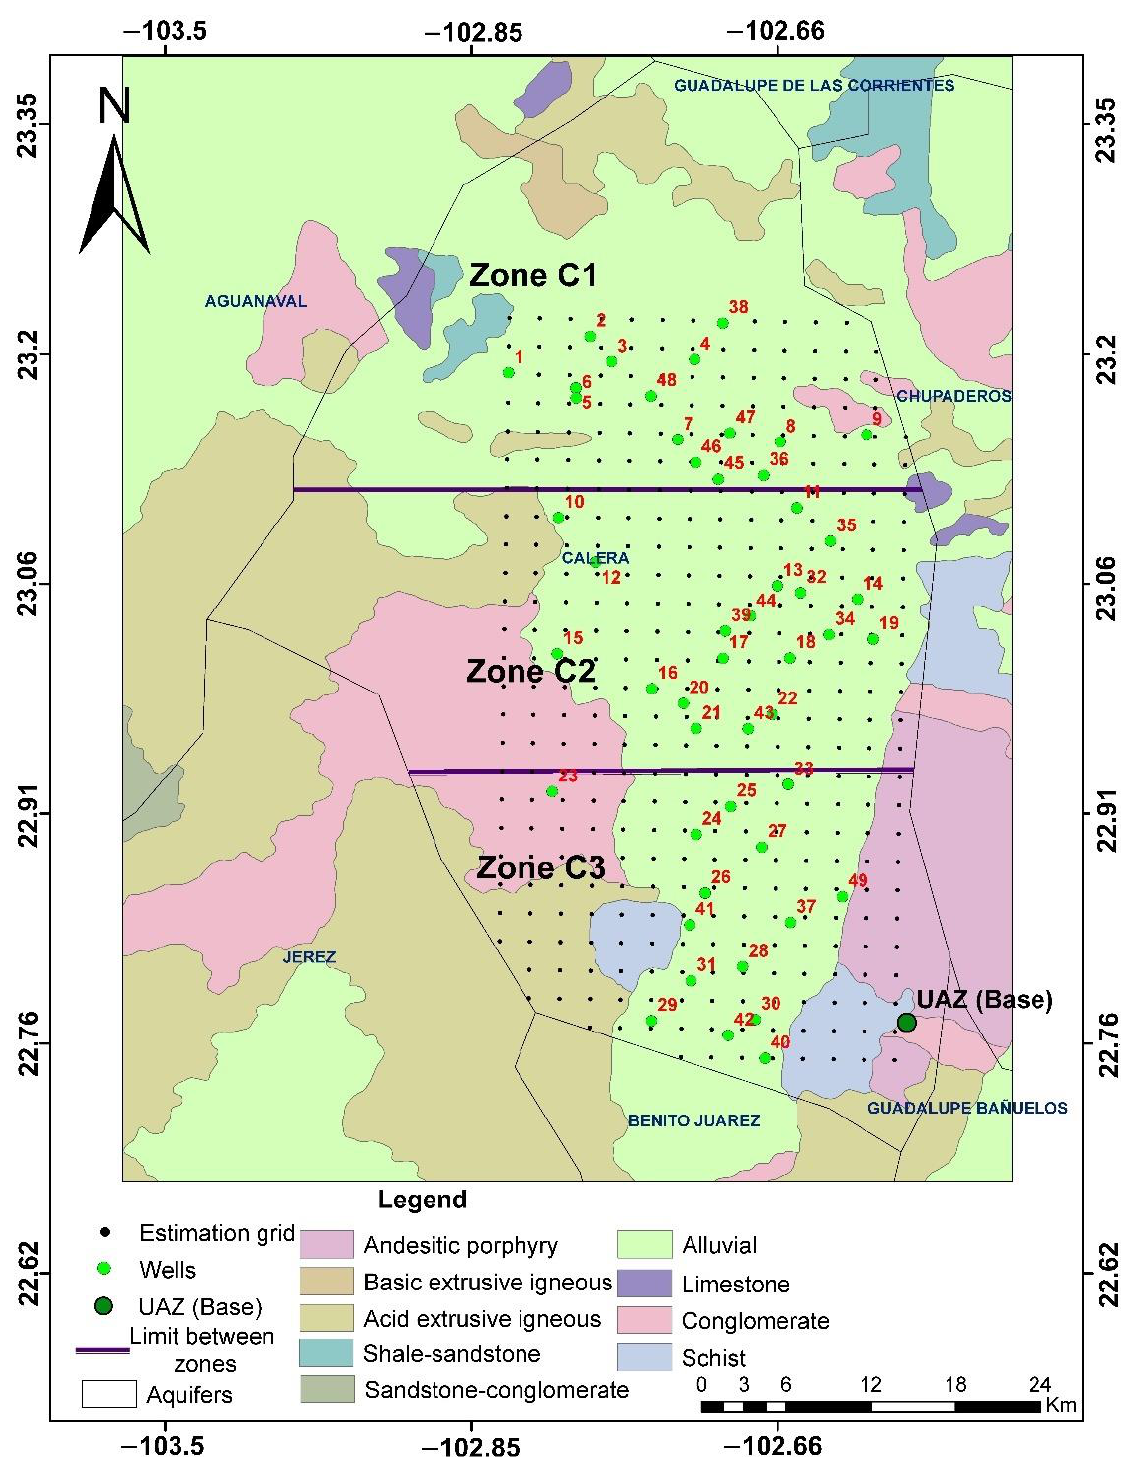
Figure 2. Monitoring sites, estimation grid, and zones C1, C2 and C3 considered in the application. The MSE is the average value of the square differences between the measured and estimated